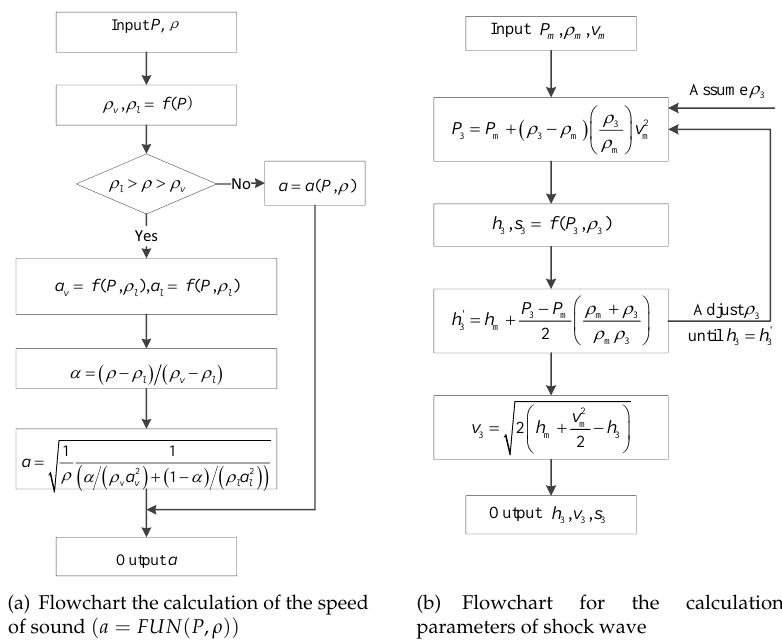
Figure 6. Sub-flowchart for calculation of the speed of sound and the parameters of shock